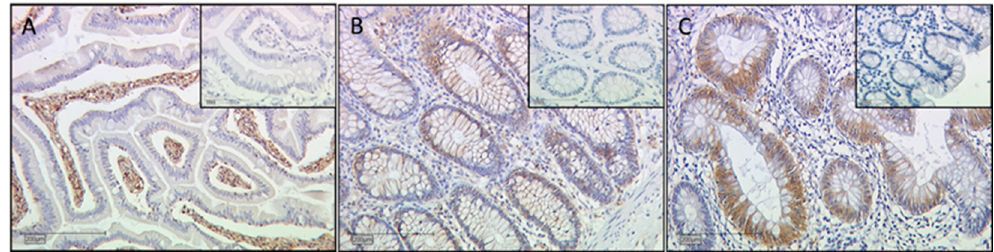
Figure 10. Control tissue for evaluation of gal-1 staining in duodenum ( A ); As a positive control for gal-2 and gal-3 expression, colon tissue was stained (( B , C ), respectively). Appropriate negative controls are shown as inserts of each